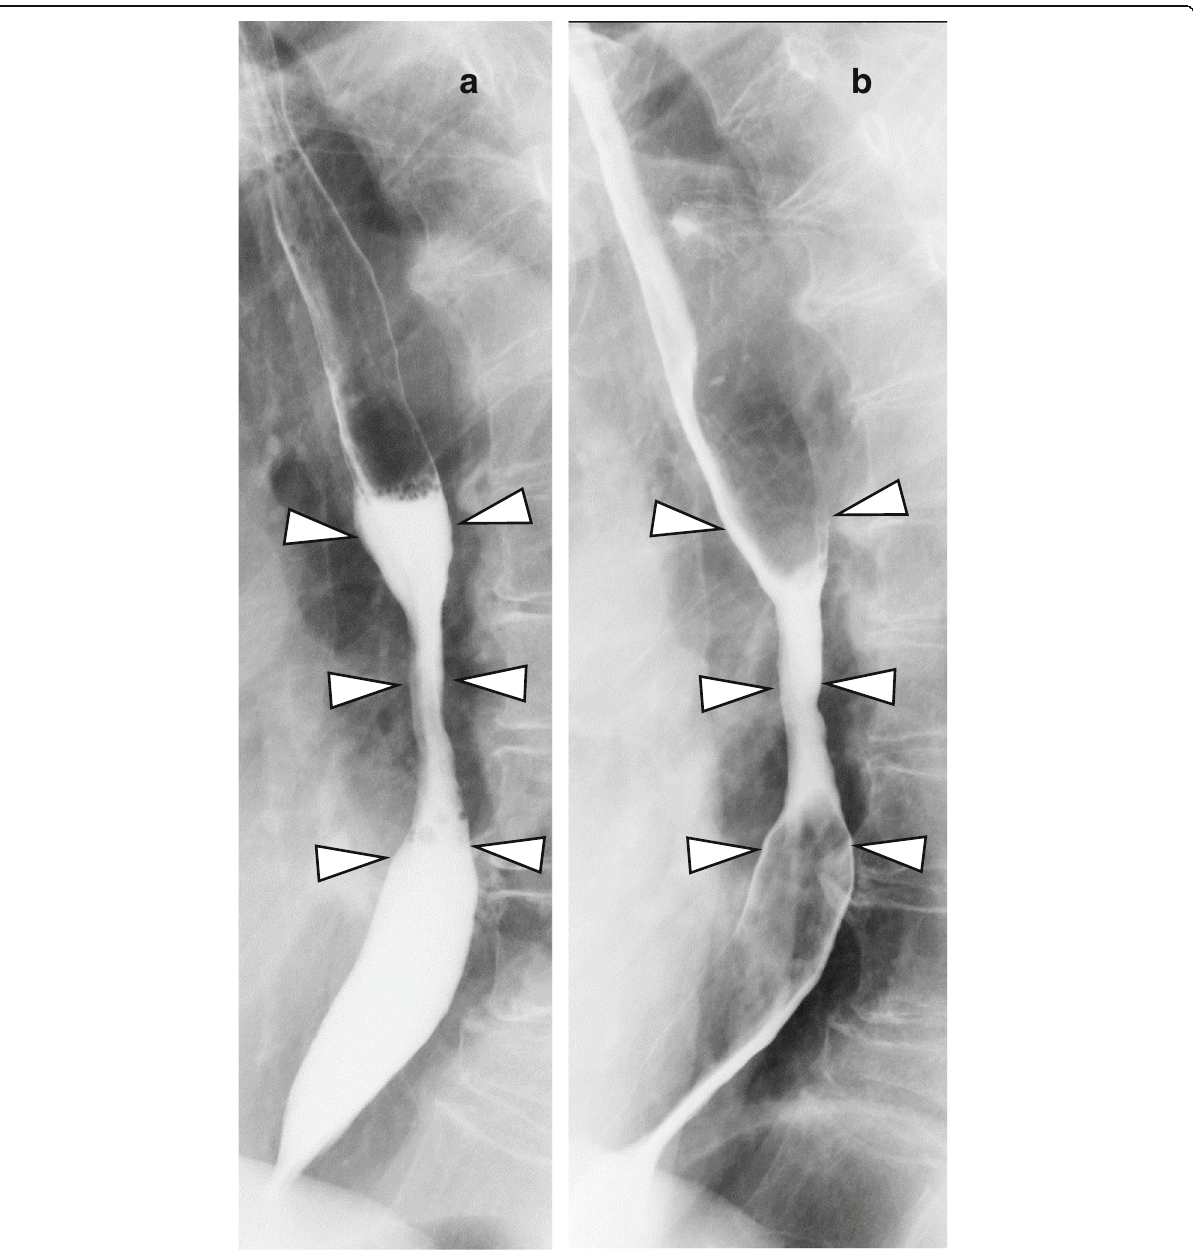
Fig. 3 Esophagography findings. Esophagography showing a mid-esophageal stenosis of more than 5 cm in length and a minimal luminal diameter around 3 mm ( a ). After 3 months of endocrine therapy, the stenosis of the esophageal lumen is improved ( b